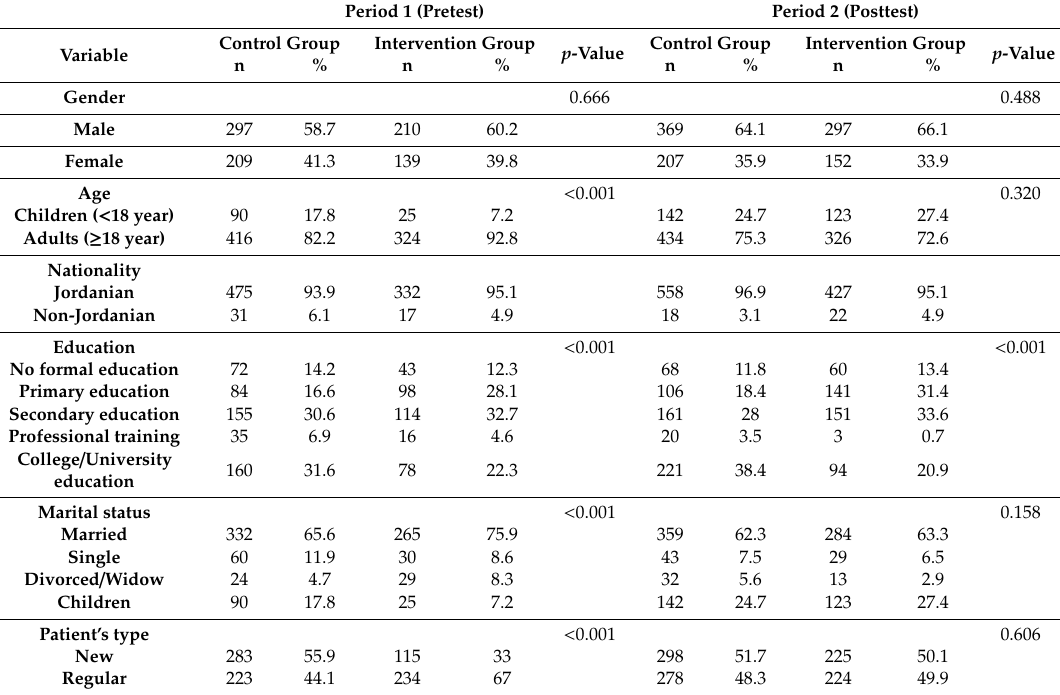
Figure 1. A flow chart that explains the design of the study. Table 1. The socio-demographic characteristics of patients in the control and intervention groups during period 1 and period